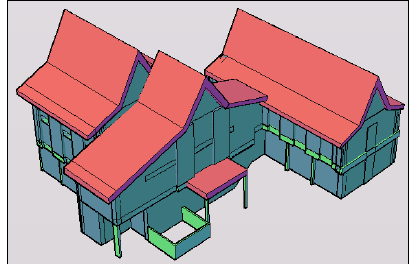
Figure 17 The complete 3D